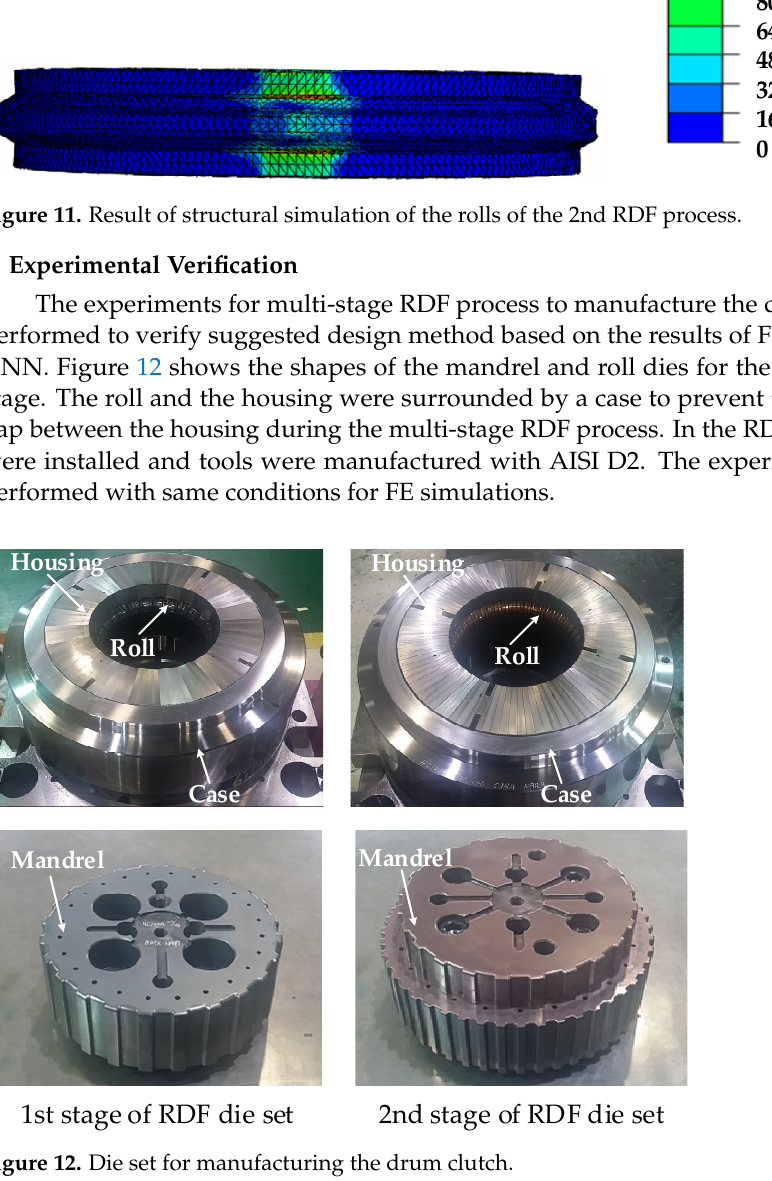
Figure 12. Die set for manufacturing the drum clutch.